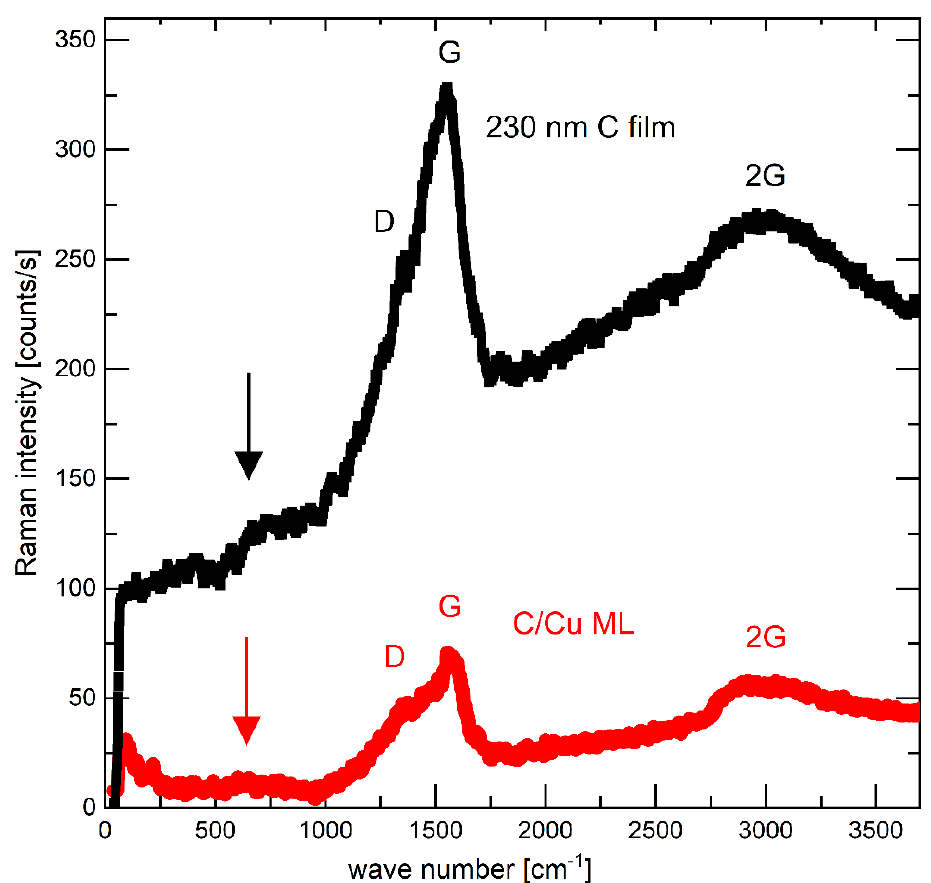
Figure 1. Raman spectra of the as-deposited 230 nm carbon film (upper black curve) and the electrode with a C/Cu ML (lower red curve) in the delithiated state of charge (SOC) after 542 lithia- tion/delithiation cycles, after washing the electrode, respectively, with solvent PC and acetonitrile, and after air exposure for 15 months. A color version of this figure can be viewed online.